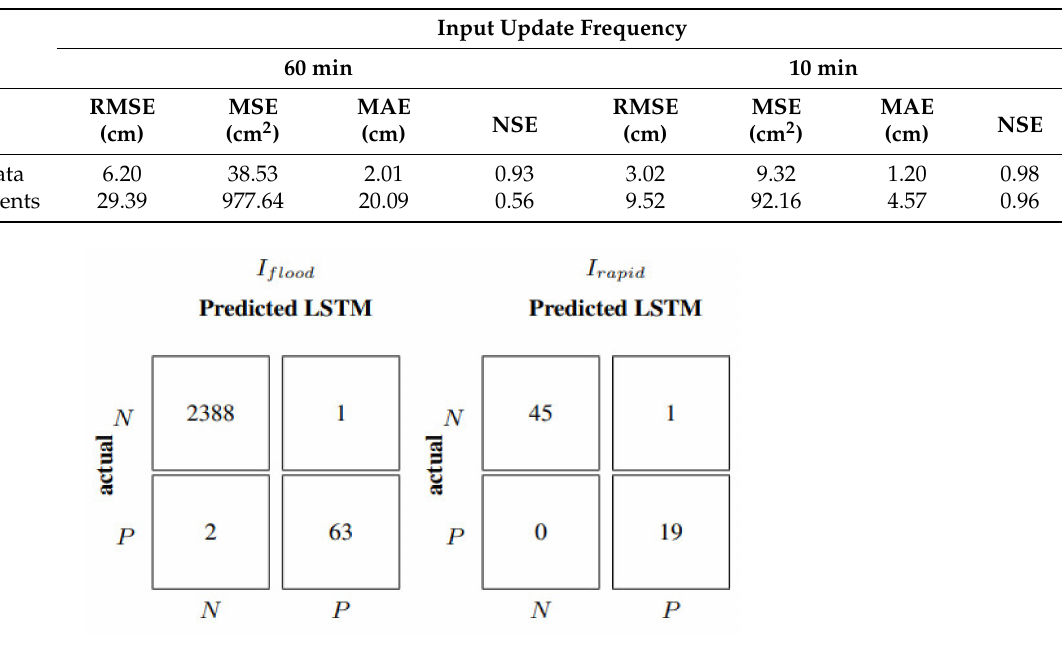
Figure 10. I flood and I rapid for the multivariable LSTM model with 10-min input update frequency. Lura test data, rain gauges scenario. P means a flood or a rapid event is present, N means that it is not.